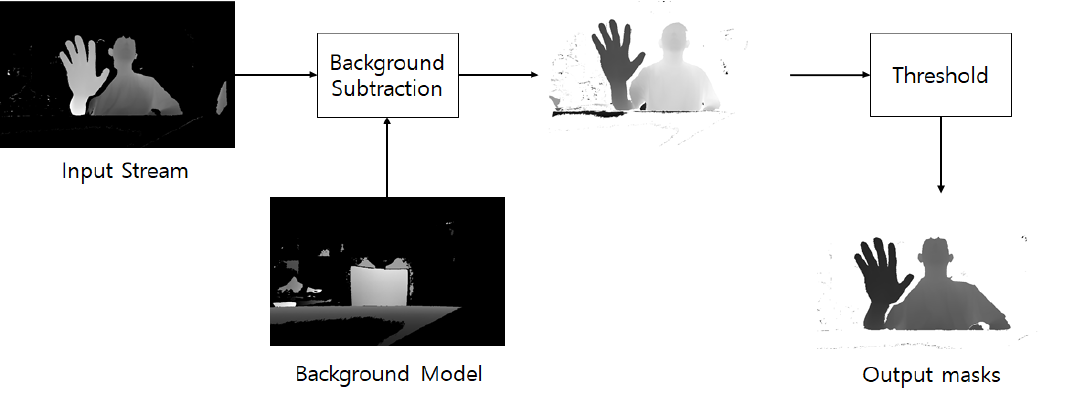
Figure 6. Background